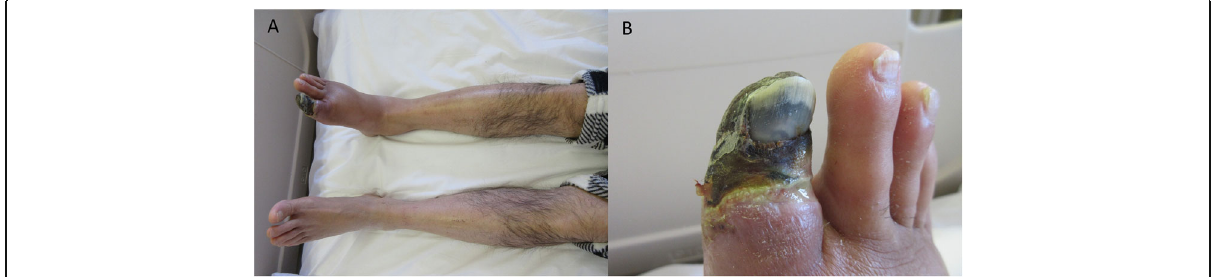
Fig. 3 Findings of the lower limb in the case 2. a, b His right foot had gangrene on his first toe and was accompanied by edema and poor